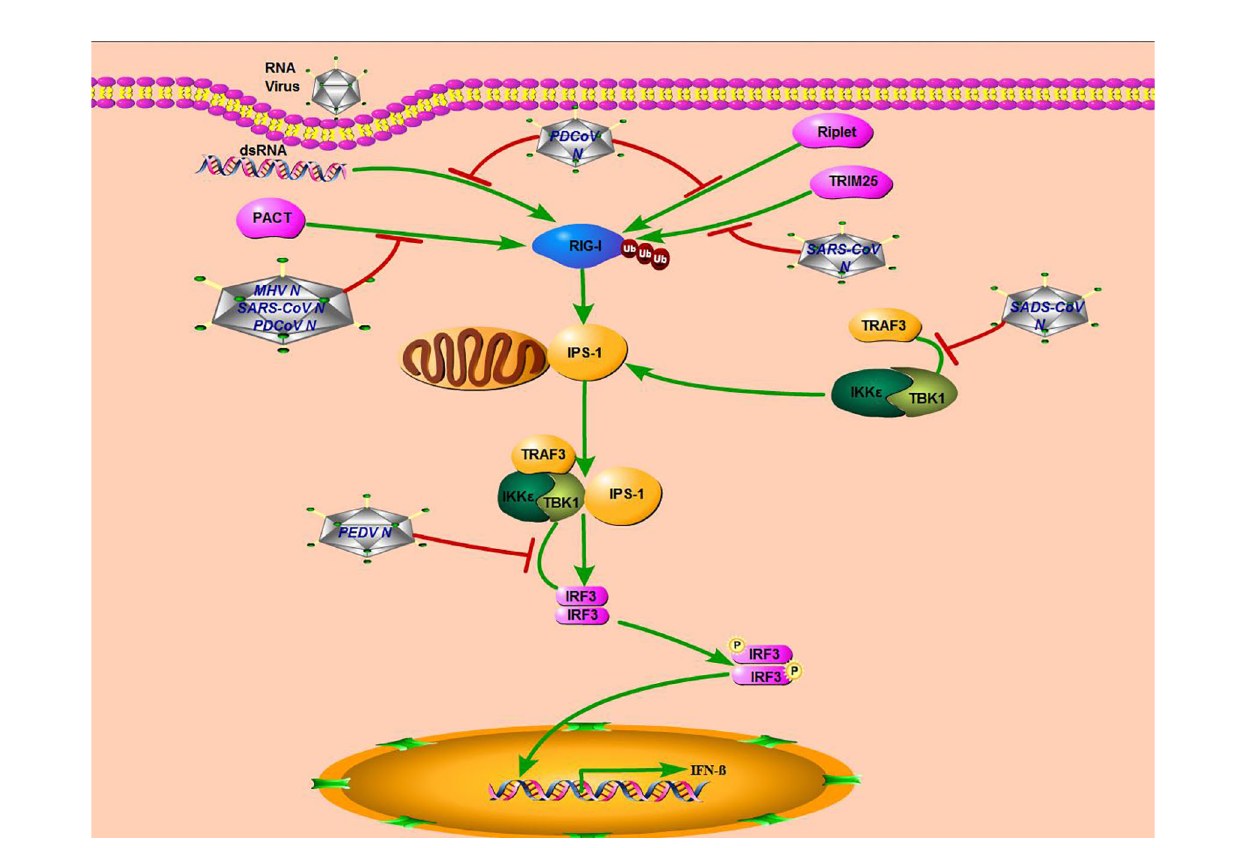
FIGURE 7 | Mechanisms of coronavirus N protein inhibiting IFN- b production. SARS-CoV, MHV, and PDCoV inhibit interferon production by targeting molecules upstream of the RLR signaling pathway (RIG-I), while PEDV and SADS-CoV, which belong to the genus Alphacoronavirus, inhibit interferon production by targeting molecules downstream of the RLRs signaling pathway